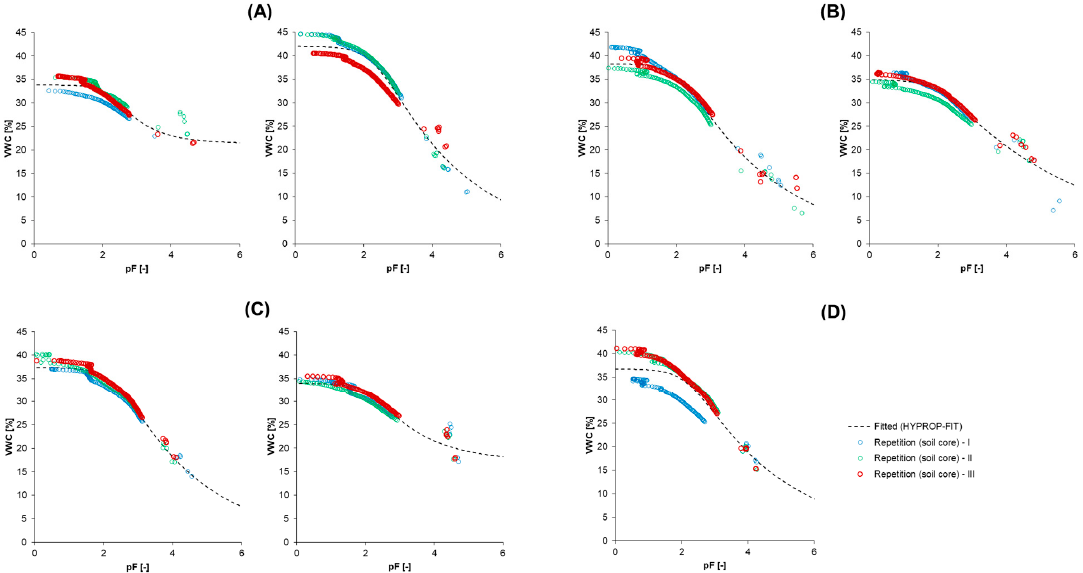
Figure 3. Exemplary differences in soil water retention points and curves obtained in the laboratory by the evaporation method and fitted soil water retention curve with three repetitions each (Repetition (I) to Repetition (III)) for: ( A ) different positions at the same row and depth: backslope and footslope (row I) at 60–90 cm; ( B ) different rows at the same depth and position: hilltop (row I & row II) at 40–60 cm; ( C ) different depth at the same row and position: backslope at 0–20 cm and 40–60 cm (row I); and ( D ) one location, depth and position: backslope at 0–20 cm (row III) at the SUPREHILL observatory. Even if smaller differences were found between the triplicates from each sample location (depth and row) larger differences between the retention characteristics were found between the sampled rows (Figure 3). The stated soil heterogeneity is confirmed with field data, where the differences are more noticeable (Figure 4) for rows and hillslope positions.